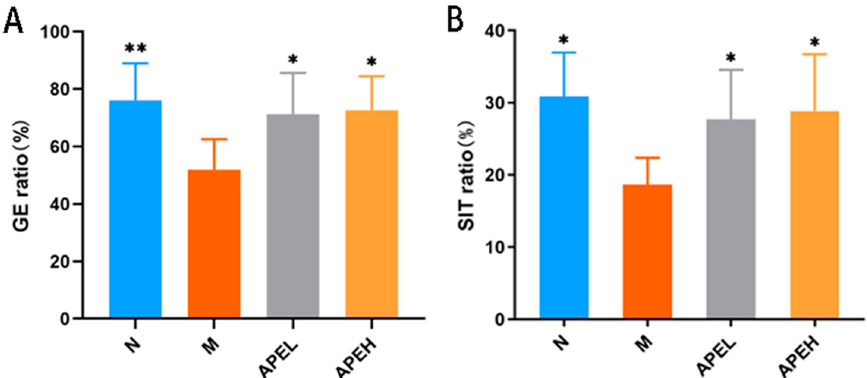
Figure 2. Effect of APE on GE ratio ( A ) and SIT ratio ( B ) in FD mice ((*) p < 0.05 and (**) p < 0.01 compared to the model group). (N, normal group; M, model group; APEL, 150 mg/kg APE group; APEH, 300 mg/kg APE group).